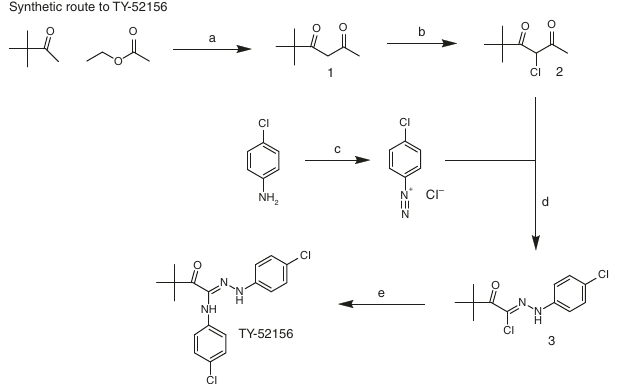
Fig. 10 Synthetic route to TY-52156. Reagents and conditions: a potassium t -butoxide, diisopropyl ether; b sulfuryl chloride, CHCl 3 ; c HCl, water, sodium nitrite; d pyridine – water; e 4-chloroaniline, ethanol,